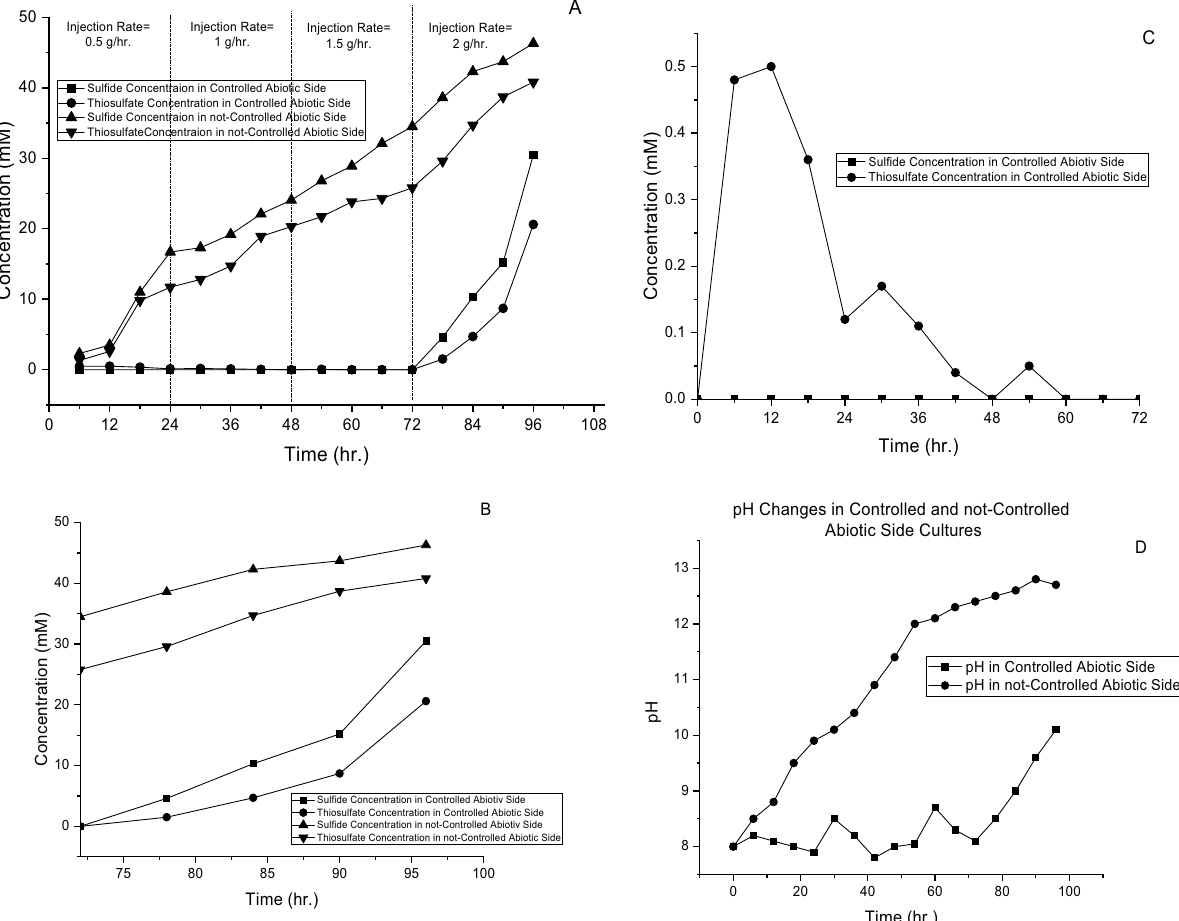
Figure 11. Results of cell culture under obtained abiotic conditions. ( A ) Results of sulfide and thiosulfate concentrations for all 4 days with different injection rates. ( B ) First 3 days of injection up to 1 g/h. (Controlled Abiotic Condition). ( C ) Fourth day of culture with an injection rate of 2 g/h. (Controlled Abiotic Condition. ( D ) pH value in the culture period for the controlled and uncontrolled abiotic